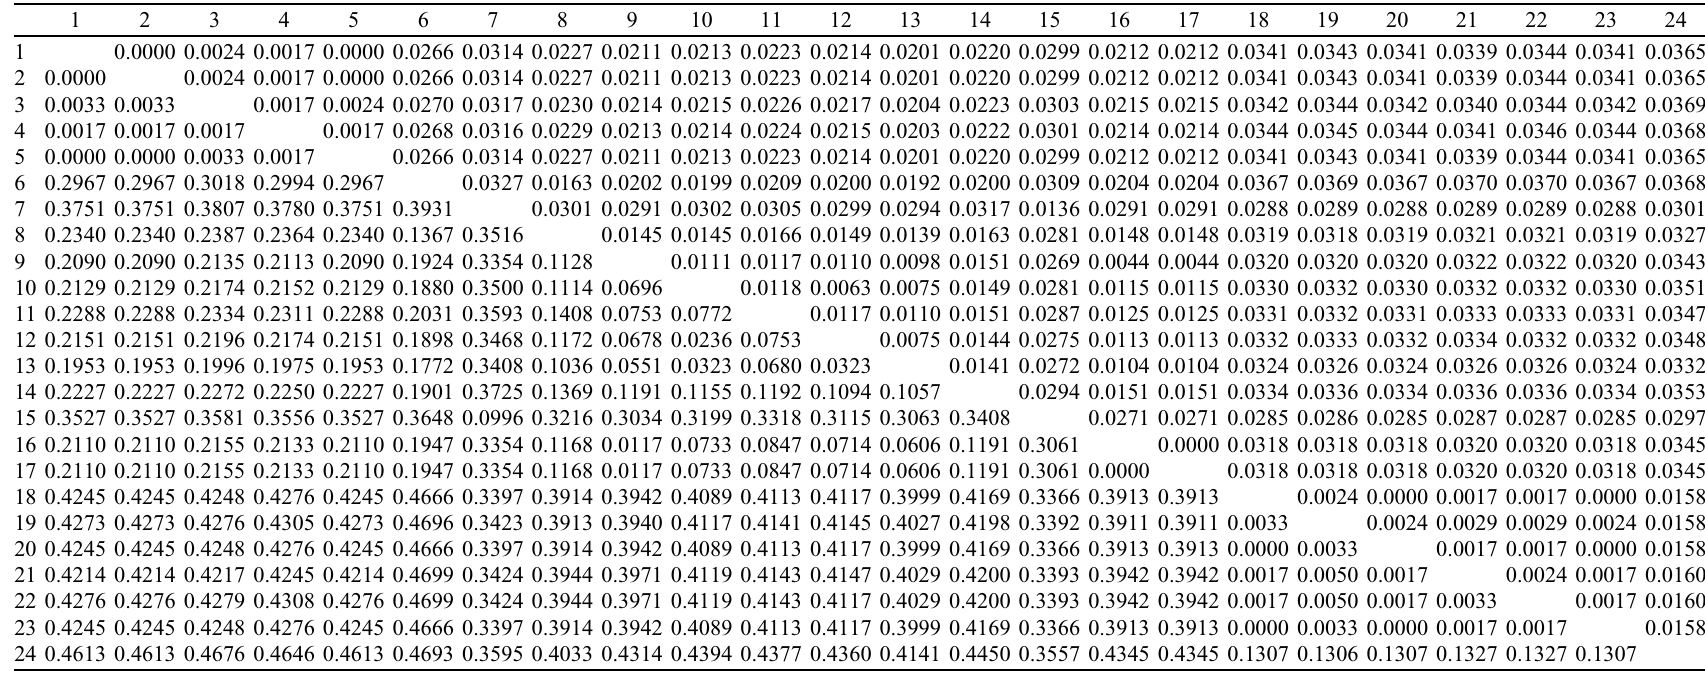
Table 2. Pairwise distance (kimura 2-parameter) matrix for the complete ITS2 sequences across all sequences from diplozoid